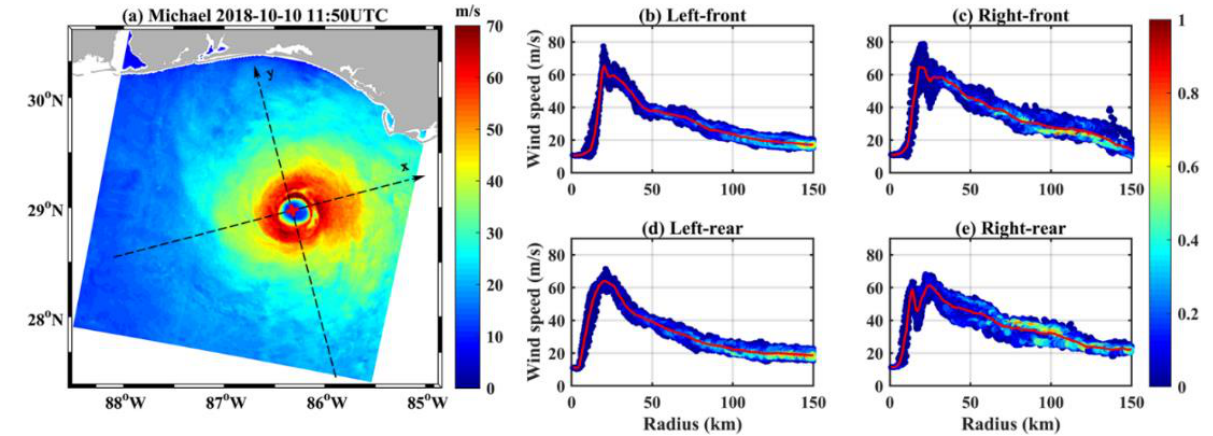
Figure 17. The same as Figure 11 but for Hurricane Michael at 11:50 UTC on 10 October